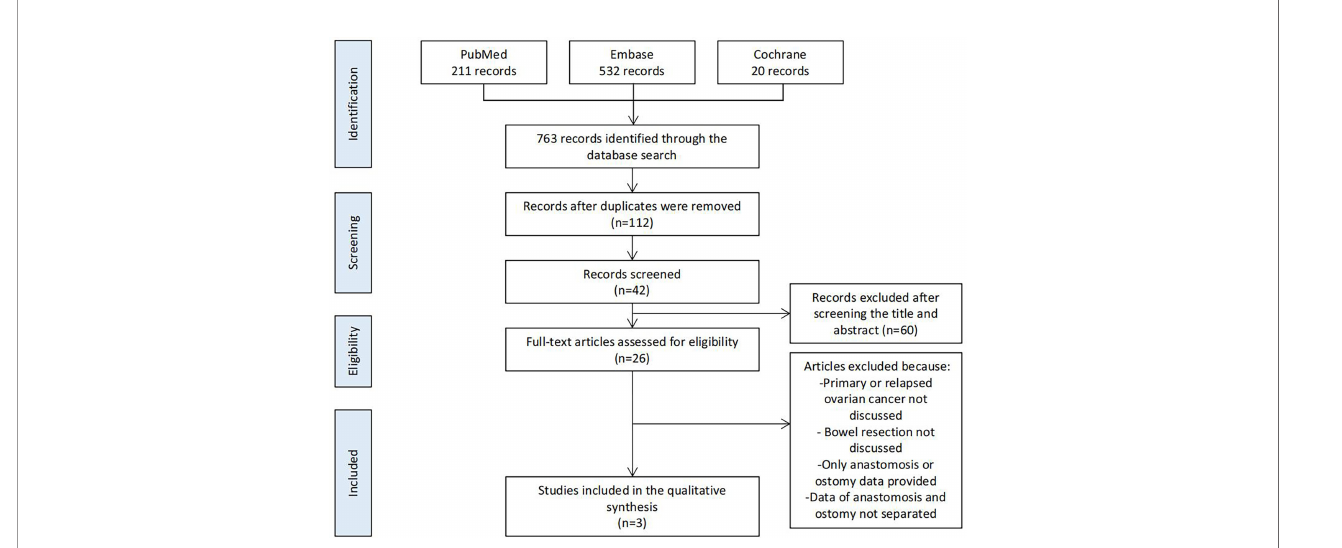
FIGURE 1 | PRISMA